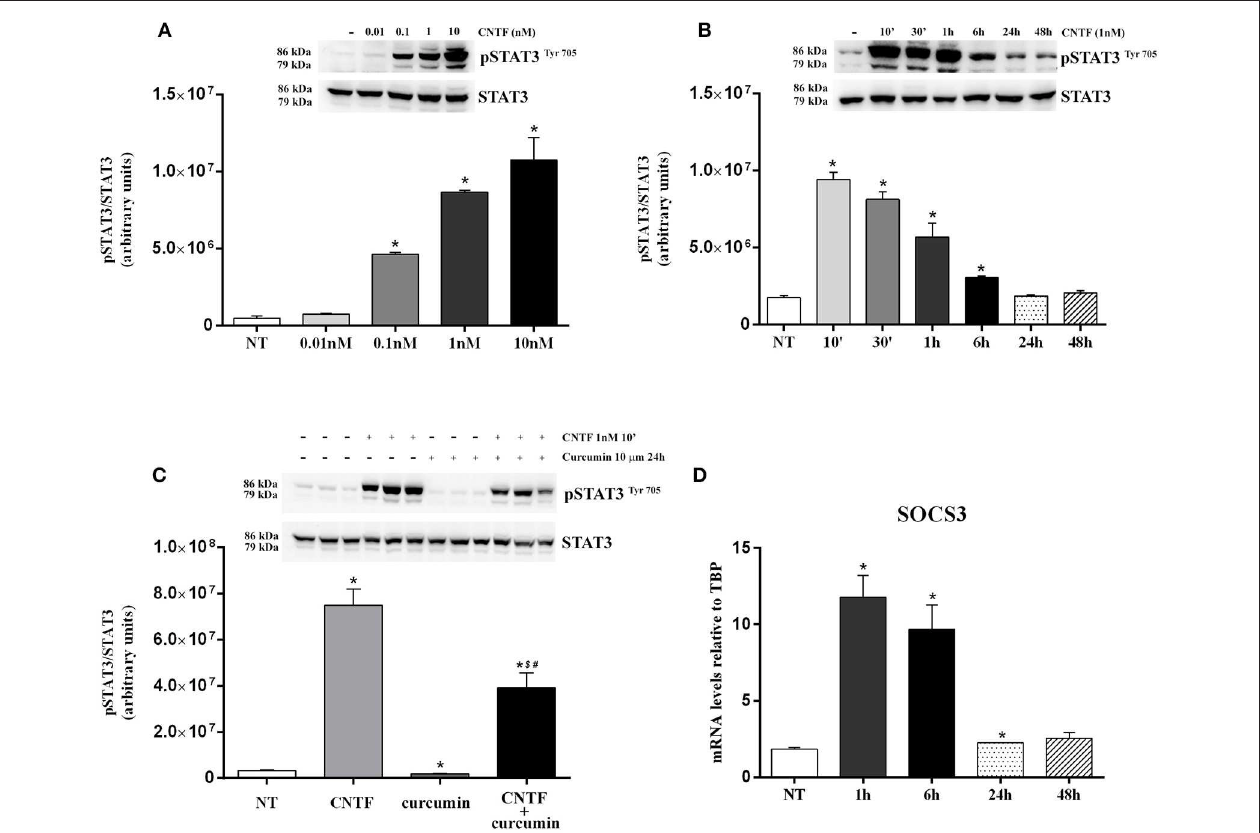
FIGURE 2 | JAK-STAT3 pathway activation in hMADS adipocytes by CNTF. (A) Representative immunoblot and quantification of the dose-dependent increase in 705-tyrosine STAT3 phosphorylation in hMADS adipocytes treated with increasing concentrations of human recombinant CNTF for 10min. Data ( n = 3) are mean ± SEM, * p < 0.05 compared with untreated cells (NT). Data were analyzed using one-way ANOVA. (B) Representative immunoblot and quantification of the time-dependent STAT3 phosphorylation in hMADS adipocytes treated with 1nM CNTF. Data ( n = 3) are mean ± SEM, * p < 0.05 compared with untreated cells (NT). Data were analyzed using one-way ANOVA. (C) Representative immunoblot and quantification of STAT3 phosphorylation as a response to 1nM CNTF treatment for 10min, detected in hMADS adipocytes pretreated with 10 µ M curcumin for 24h. Data ( n = 3) are mean ± SEM, * p < 0.05 compared with untreated cells (NT), $ p < 0.05 compared with cells treated with curcumin, # p < 0.05 compared with cells treated with CNTF. Data were analyzed using one-way ANOVA. (D) Time-dependent SOCS3 mRNA induction in hMADS adipocytes by 1nM CNTF treatment. Data ( n = 3) are mean ± SEM, * p < 0.05 compared with untreated cells (NT). Data were analyzed using one-way